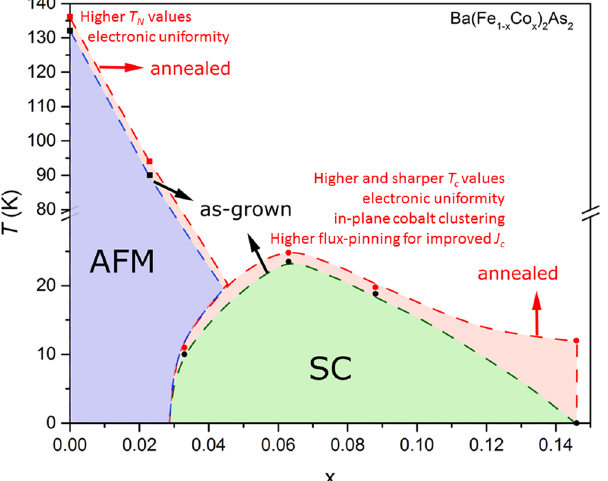
Figure 9. Annealing improves quantum transition temperatures in Ba(Fe 1 − x Co x ) 2 As 2 crystals. For all crystals, the overall lattice strain can be removed while the electronic structures become more uniform. While the in- plane cobalt chemical clustering can improve pinning, it seems to also raise the overall superconducting (SC) dome by giving paths for better percolation. Homogeneity improves antiferromagnetic transition